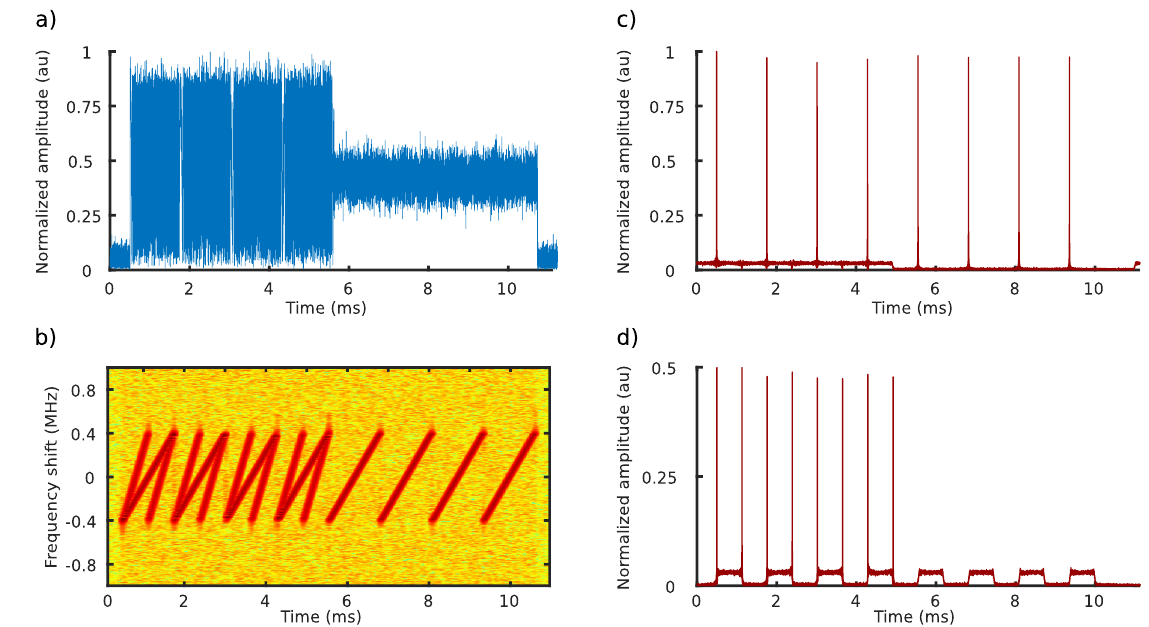
Figure 1. Two received Long Range (LoRa) signals constitute eight preamble upchirp symbols at 2.4GHz with a bandwidth equal to 812kHz. The spreading factor (SF) of the short signal, which ended after approximately 5ms, is equal to 9, while the SF of the long-duration signal is equal to 10. Figures ( a ) and ( b ) represent the combined received signals in the time domain and in the spectrogram (i.e., time and frequency) domain, respectively. Figures ( c ) and ( d ) are the cross-correlation functions (6) when the received signals have been cross-correlated with base chirps of the SF equal to 10 and 9,